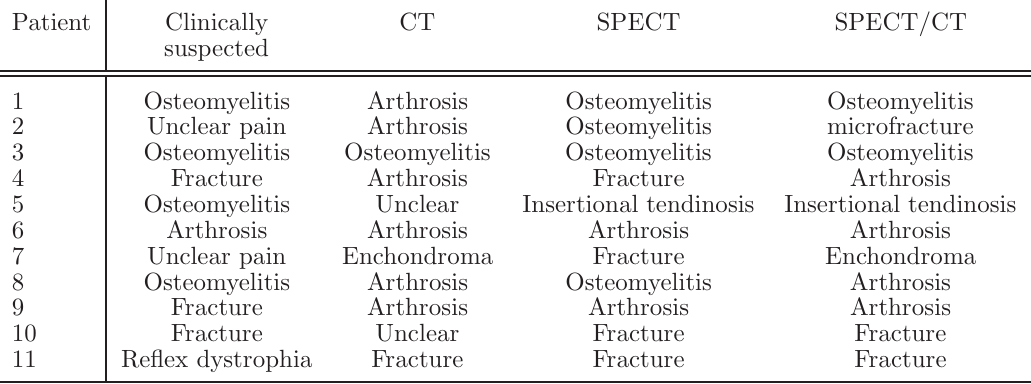
Table 2 Clinically suspected main diagnoses, and CT, SPECT and SPECT/CT diagnosis: Patient Clinically CT SPECT